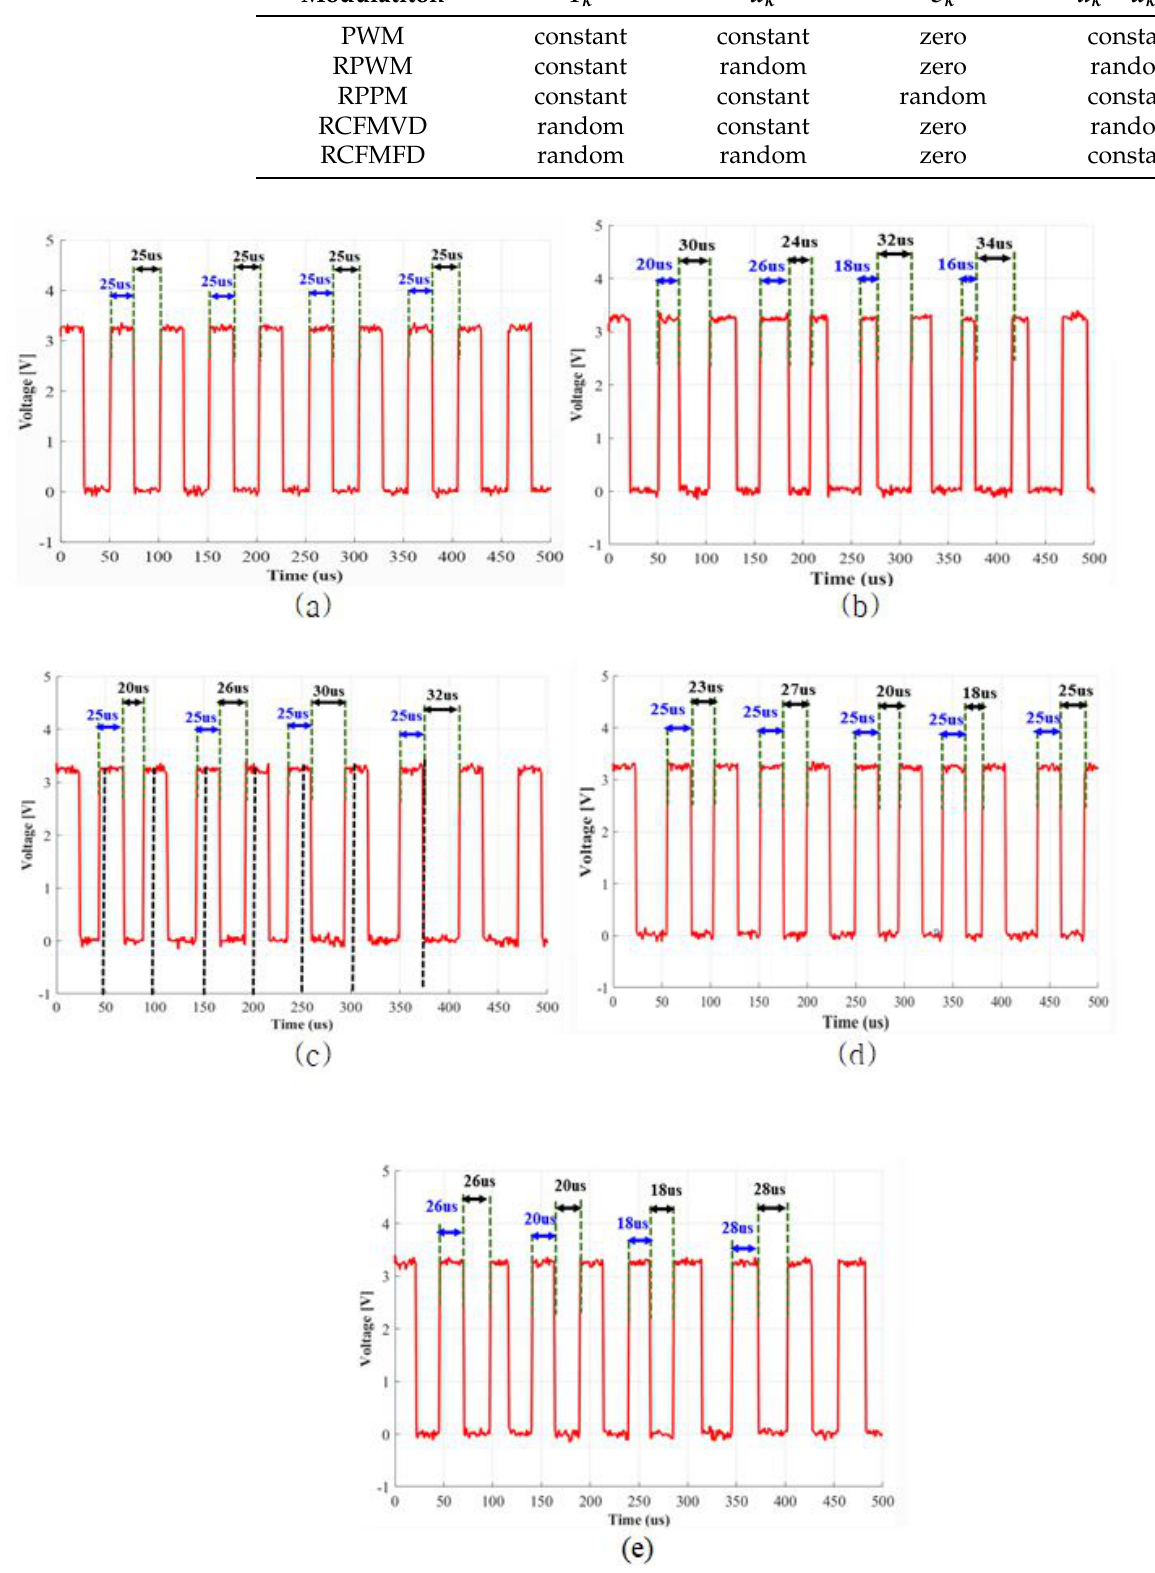
Figure 5. Switching modulation signals from Arduino for a simple buck converter operation: ( a ) PWM, ( b ) RPWM, ( c ) RPPM, ( d ) RCFMVD, and ( e )